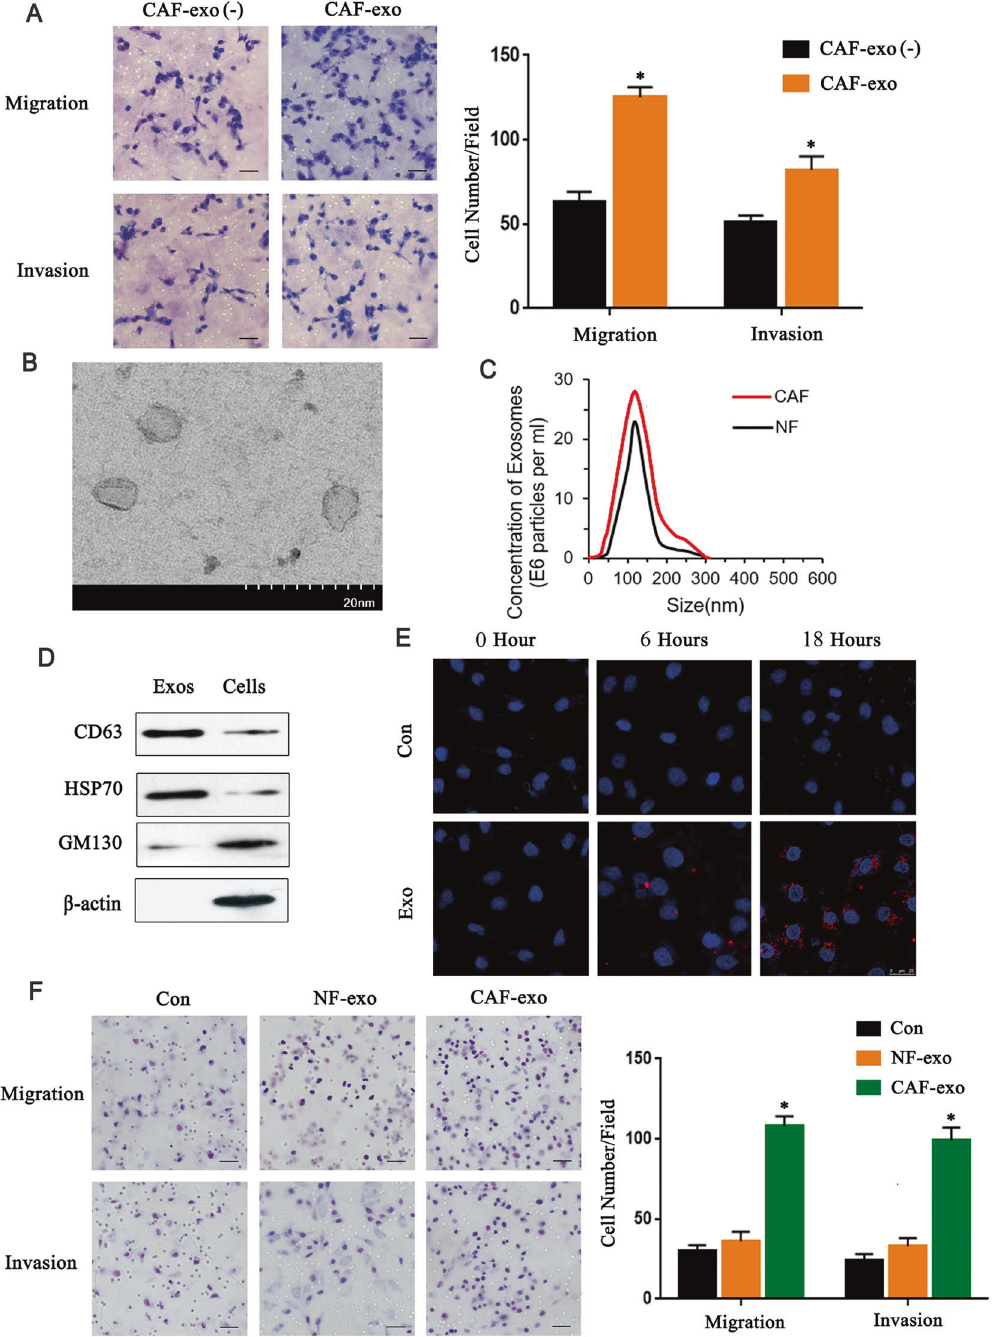
Fig. 2 CAFs derived exosomes enhance invasion and migration of breast cancer cells. A Transwell experiments analyzed the effects of exosomes on the invasion and migration ability of breast cancer cells ( n = 3). Scale bar, 50 μ m. B Electron microscopic image of exosomes isolated. Scale bar, 20 nm. C The particle size distribution and counts were evaluated by Tunable Resistive Pulse Sensing ( n = 3). D Western blot detected the expression of exosomes and cells markers in CAFs-derived exosomes and fi broblasts ( n = 3). E Immuno fl uorescence imaging shows DiD-labeled exosomes and cell uptake of exosomes ( n = 3). Scale bar, 25 μ m. F The effects of exosomes from different fi broblast sources on the invasion and migration ability of breast cancer cells were analyzed by Transwell assays ( n = 3). Scale bar, 50 μ m. * indicates p < 0.05. The measurement data were expressed using mean ± SD, and the experiment was repeated three times. Comparisons between two groups are analyzed by paired t-test; one-way ANOVA was used for multiple data analysis groups.